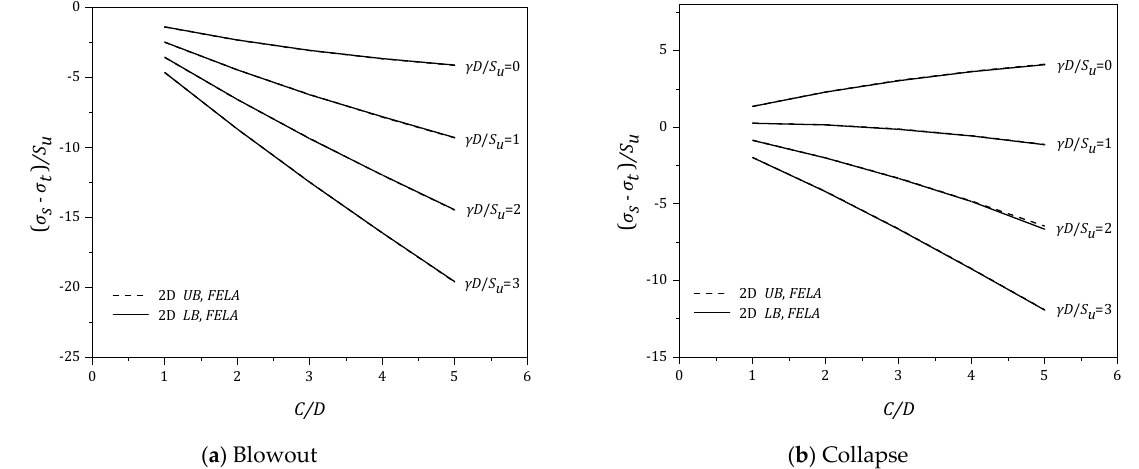
Figure 11. ( σ s − σ t )/ S u vs ( C/D ) for various ( γ D/S u ) − B/D = 1.33.